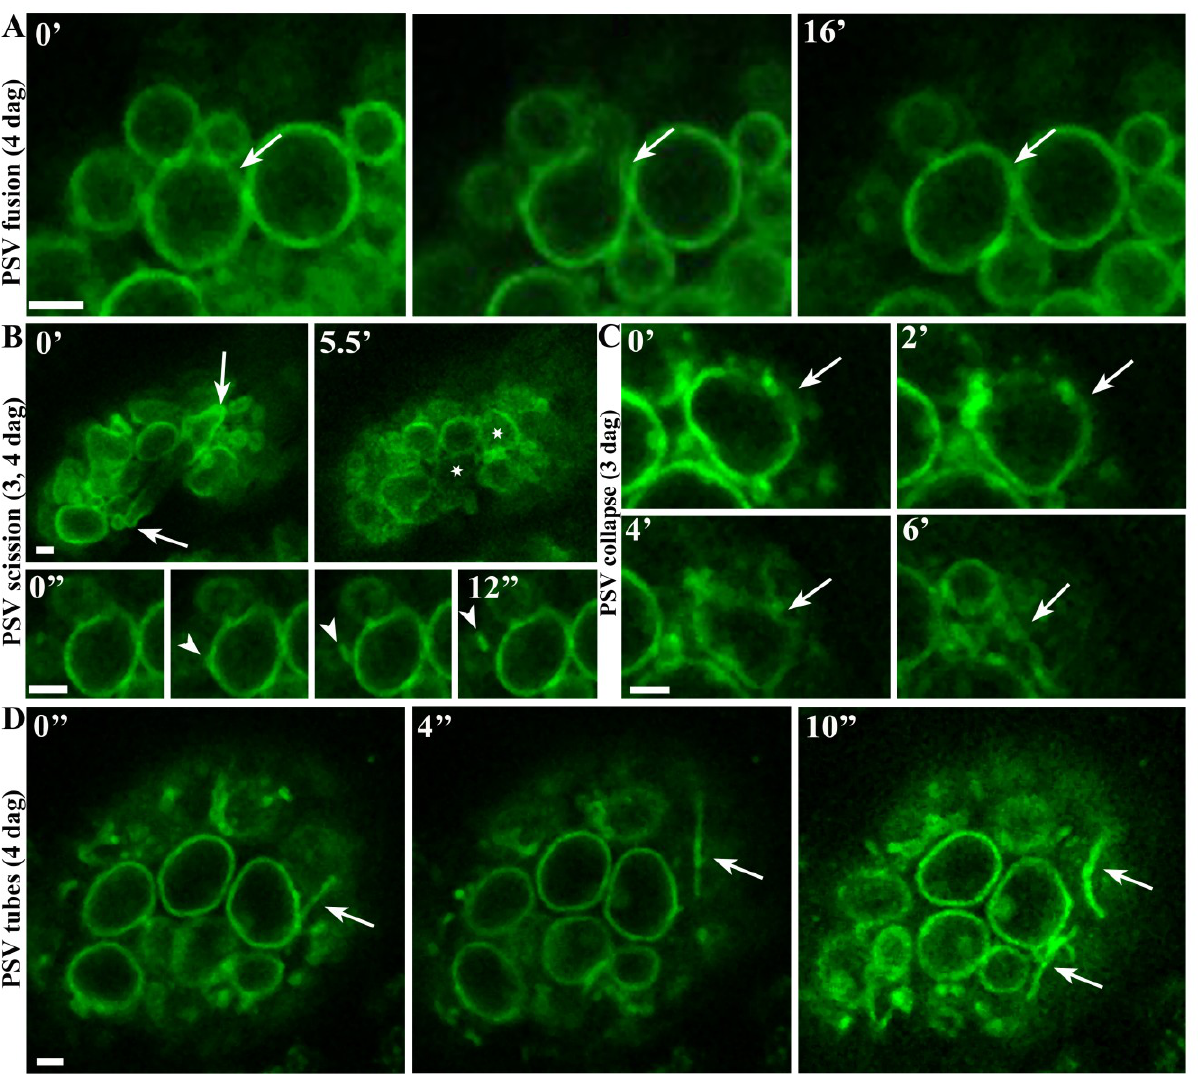
Figure 2. Live cell imaging 4 days after germination, indicating PSV fusion, scission and collapse, and the extension of tubular structures. ( A ) PSV fusion over a duration of 16 min (images captured every 4 s); ( B ) PSV apparently splitting into two PSVs (images captured every 8 s) and a TIP3-GFP-labeled vesicle budding off from another PSV (images captured every 4 s). ( C ) Potential PSV collapse over a duration of 6 min (images captured every 8 s). ( D ) Dynamic behavior of tubular extension structures (images captured every 4 s). Scale bar = 2